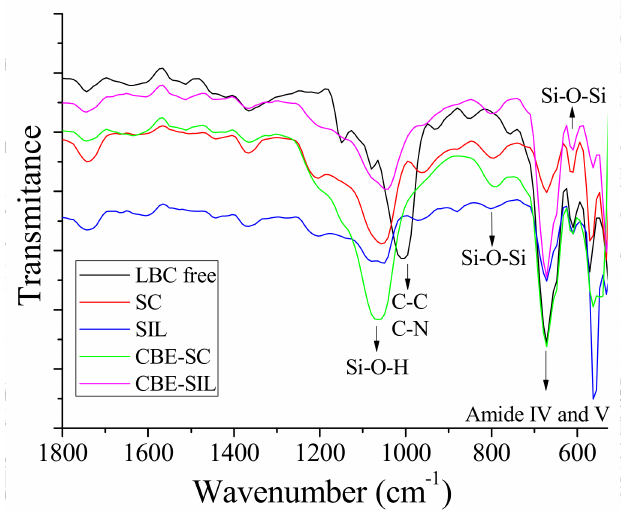
Figure 5. FTIR spectra of the lipase from Burkholderia cepacia (LBC free), control silica (SC), silica produced with protic ionic liquid (SIL), lipase immobilized by covalent binding with epichlorohydrin onto silica control (CBE-SC) or lipase immobilized by covalent binding with epichlorohydrin onto silica produced with protic ionic liquid (CBE-SIL).